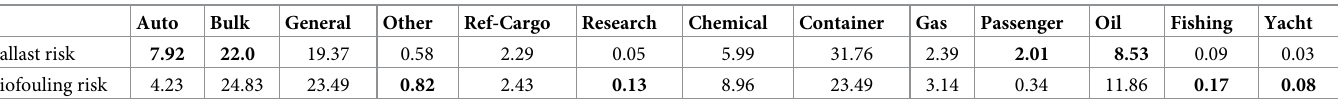
Table 2. Percentage of each ship type in the data for calculation of ballast and biofouling risk. Percentage values for ship types with an overall higher NIS introduction risk (as identified in Fig 8) are marked as bold. We notice that most ship types with higher introduction risk (via ballast or biofouling) do not make a large portion of the